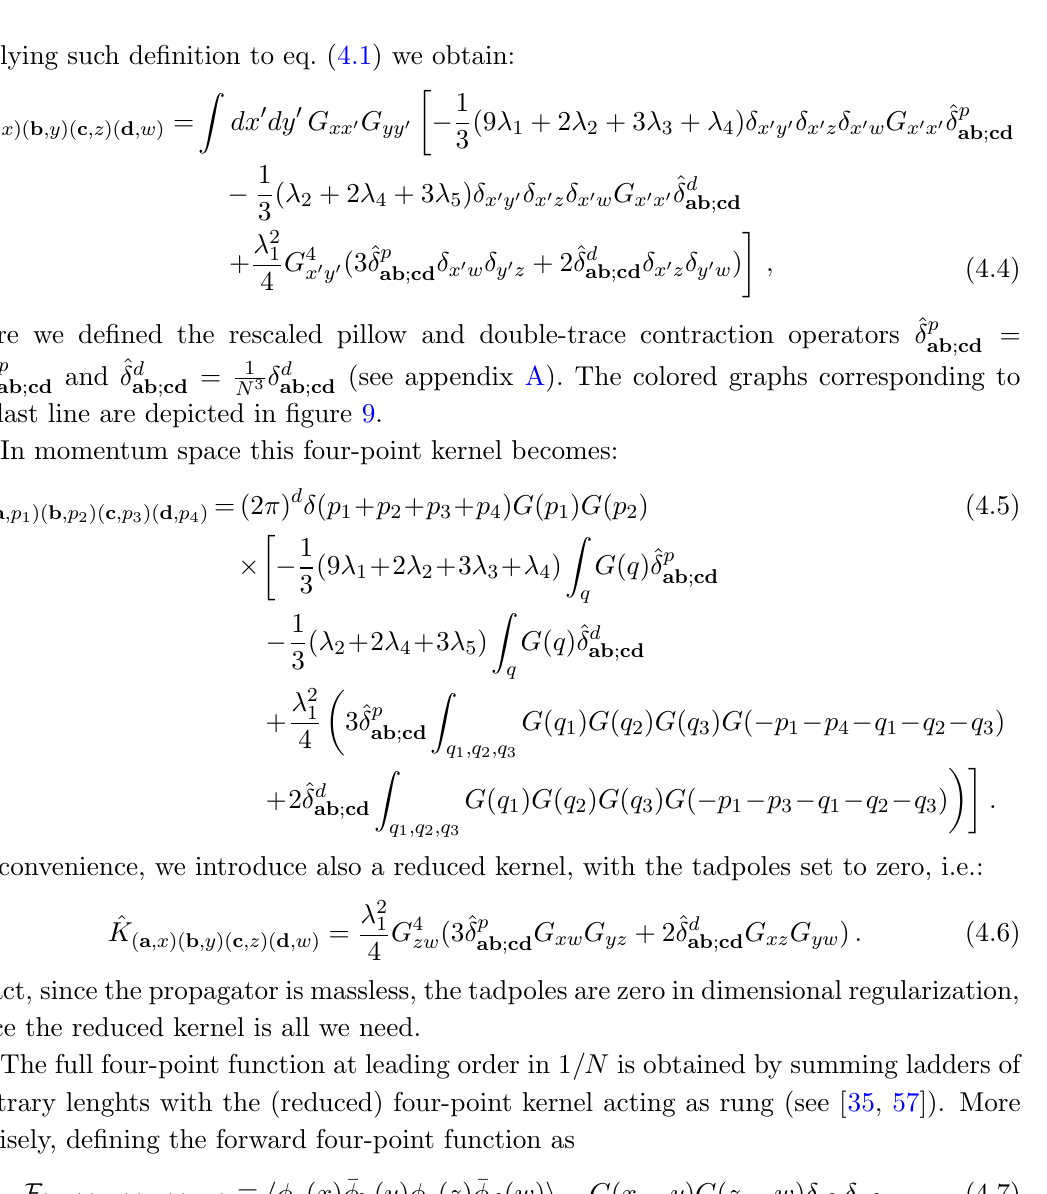
Figure 9. The contractions corresponding to a 4-point rung in the ladder making the 4-point function (a pillow on the left and a double trace on the